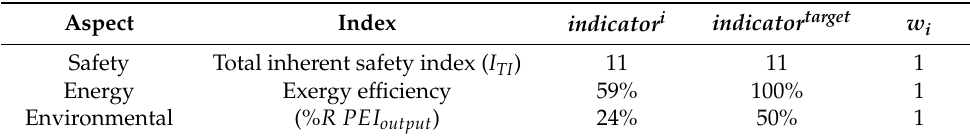
Table 4. Corresponding parameters, indicators, and the weighting factor for each technical parameter. Aspect Index indicator i indicator target w i Safety Total inherent safety index ( I TI ) 11 11 1 Energy Exergy efficiency 59% 100% 1 Environmental (% R PEI output ) 24% 50%